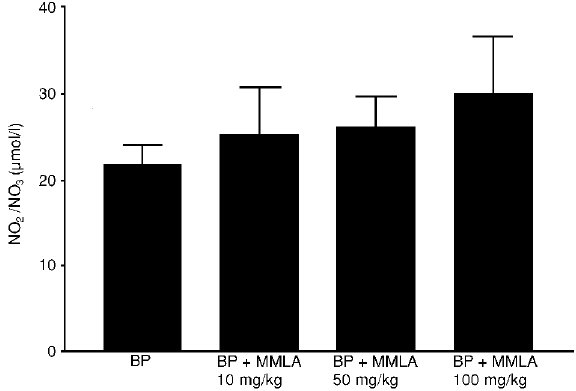
FIG. 3. Levels of NO 2 /NO 3 in the BAL fluid of mice infected with B. pertussis , and treated with MMLA, at various concentrations in a single dose intraperitoneally. Mice were sacrificed 10 days after infection.